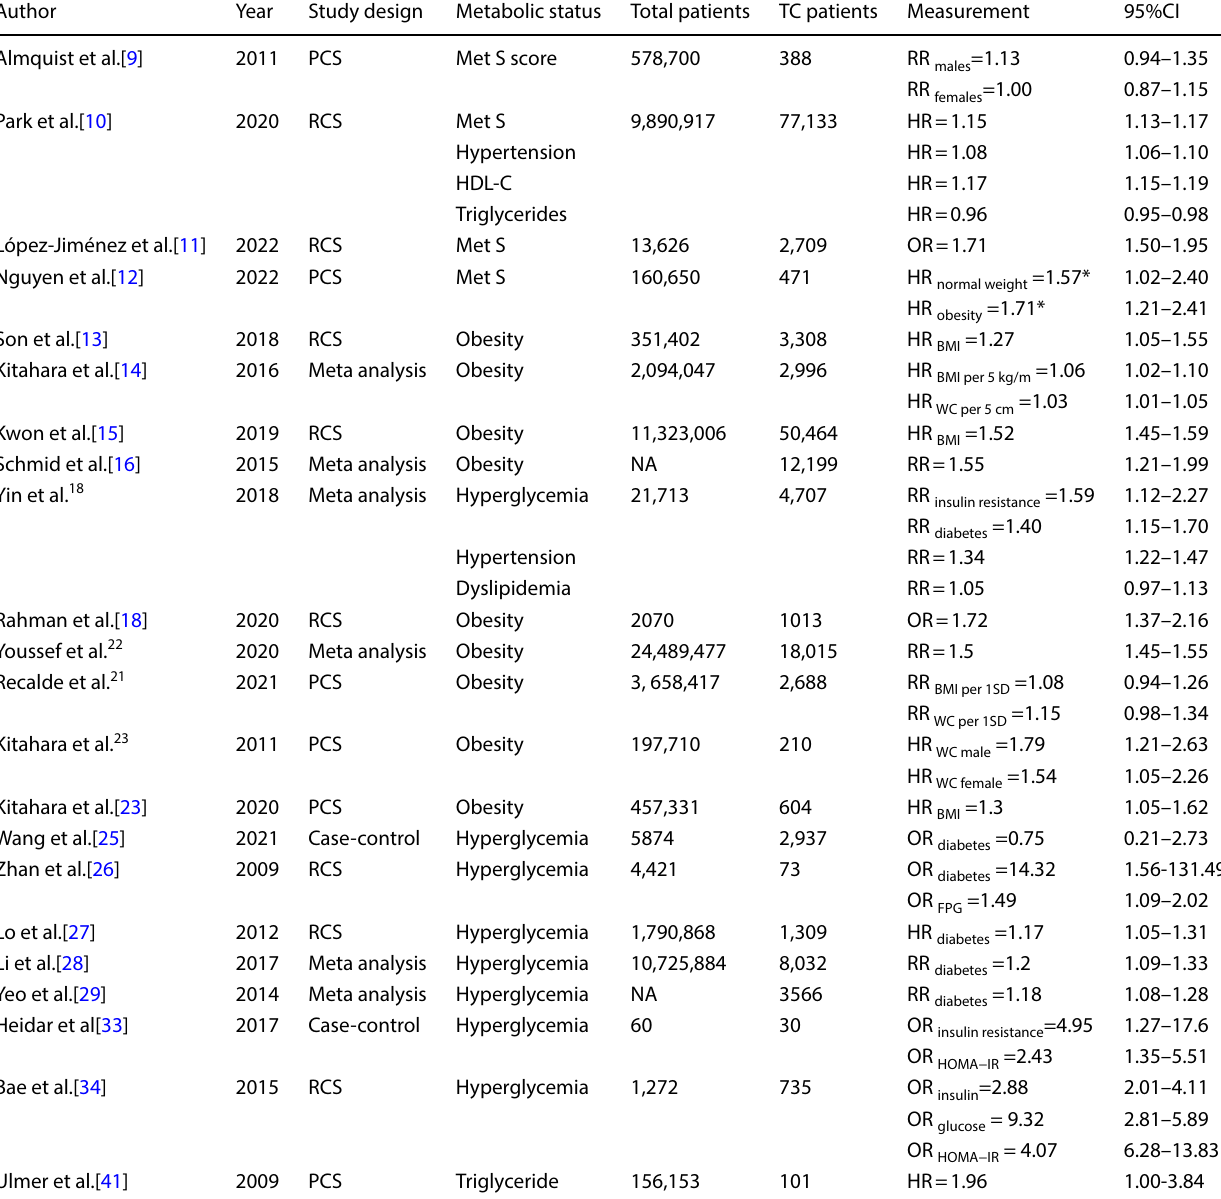
Table 1 Relationship between metabolic disorders and thyroid cancer